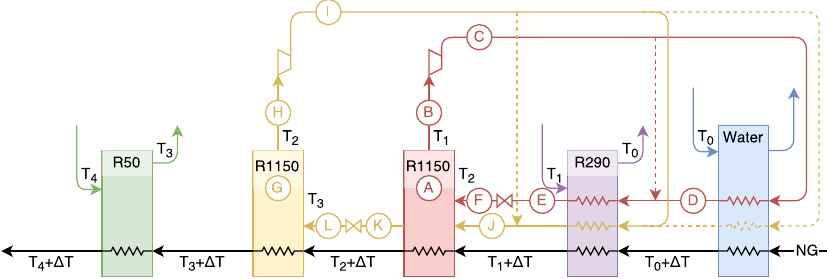
Figure 2. Optimized 1-2-1-Cascade, R1150 circuits. Optimized configuration (solid lines) and other possible configurations (dashed